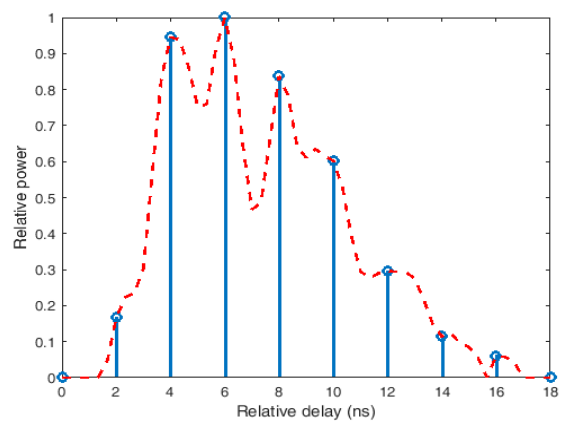
Figure 5. Example of Power Delay Profile